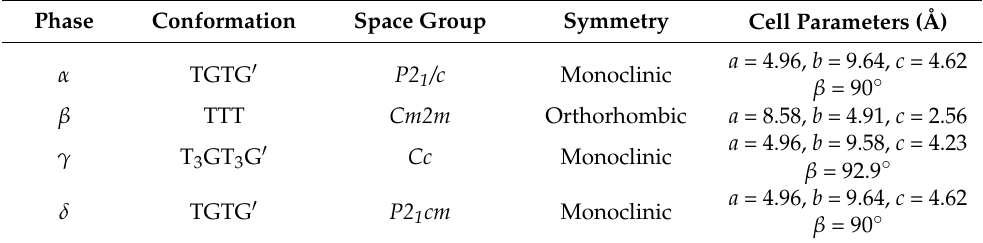
Table 1. The unit cell parameters of the common crystal phases of PVDF [39–41].